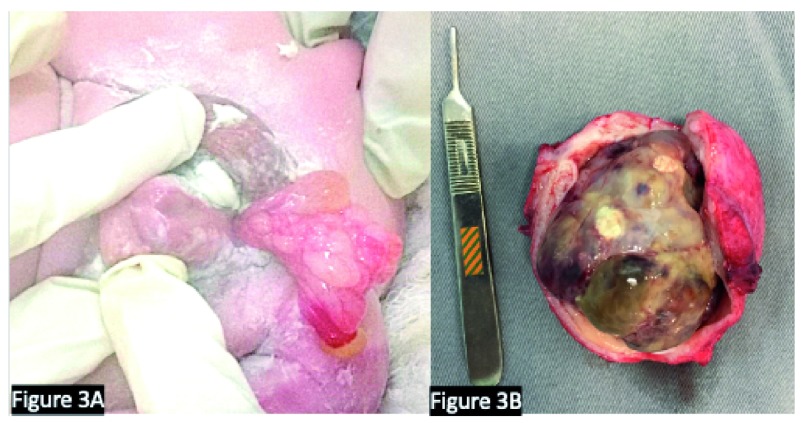
Cases of rhabdomyosarcoma.(
A) A male infant at 14 months with congenital rhabdomyosarcoma protruding through the urethra. Note the association with a proximal hypospadias. (
B) Cystoprostatectomy specimen showing extensive rhabdomyosarcoma with necrosis after neoadjuvant chemotherapy. (Surgery was performed for the tumor depicted in frame
B.) We confirm that the patients gave us permission to use these images.